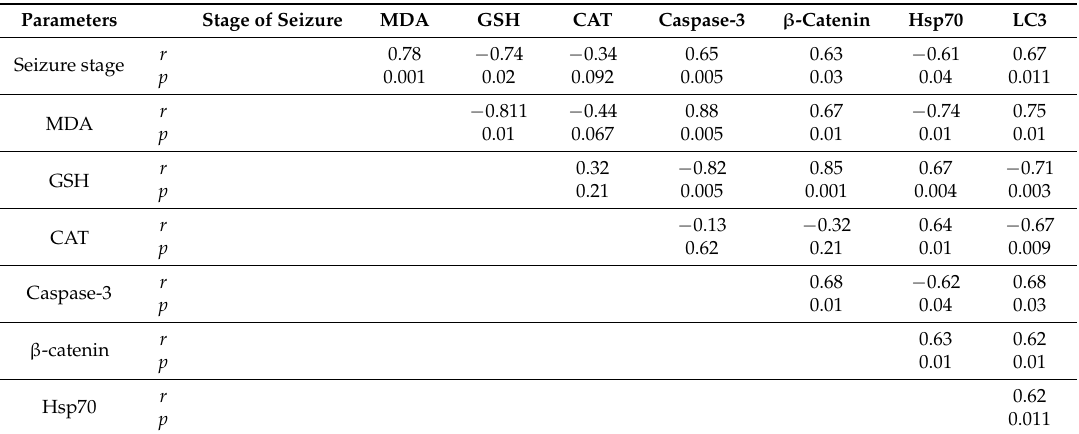
Table 1. Correlation between seizure stage and oxidative stress markers, expression of caspase-3, β -catenin, LC3 and Hsp70 in the PTZ group.